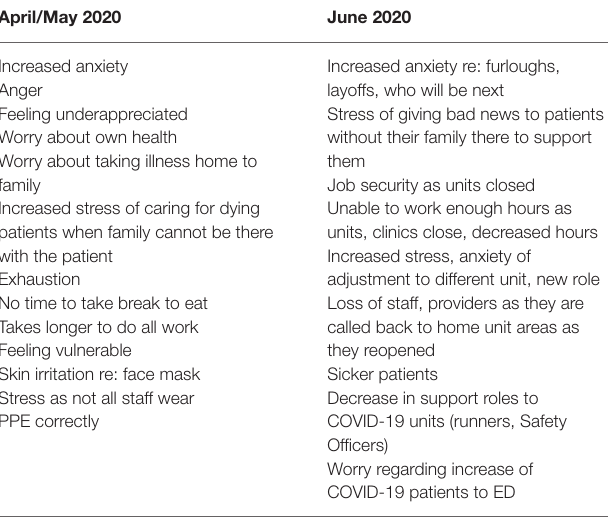
TABLE 2 | Themes that emerged from speaking with clinical staff, providers, and support staff among COVID-19 and non-COVID-19 units.